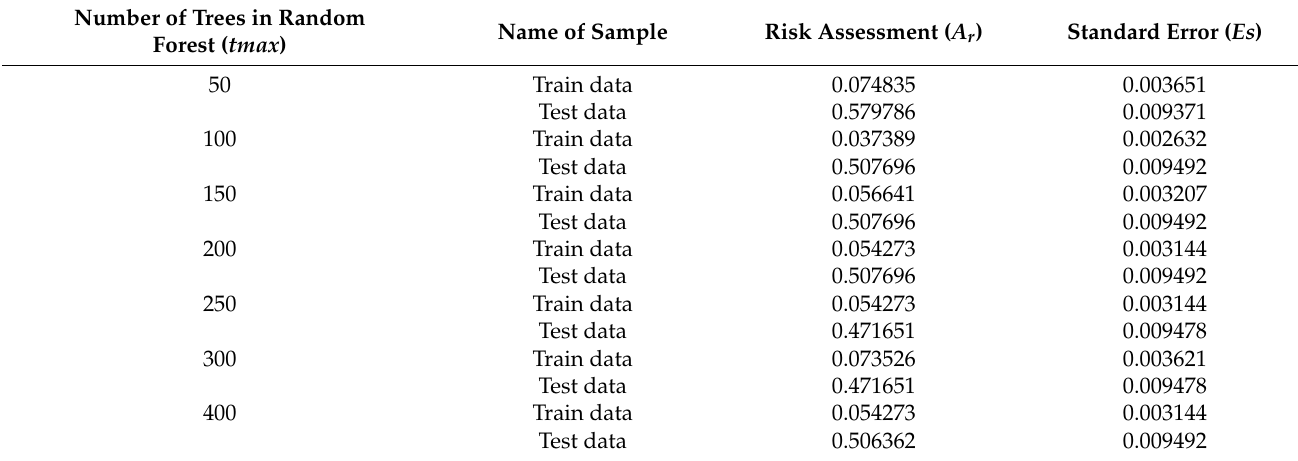
Table 2. Risk assessment for the training and test samples when constructing a random forest with different numbers of